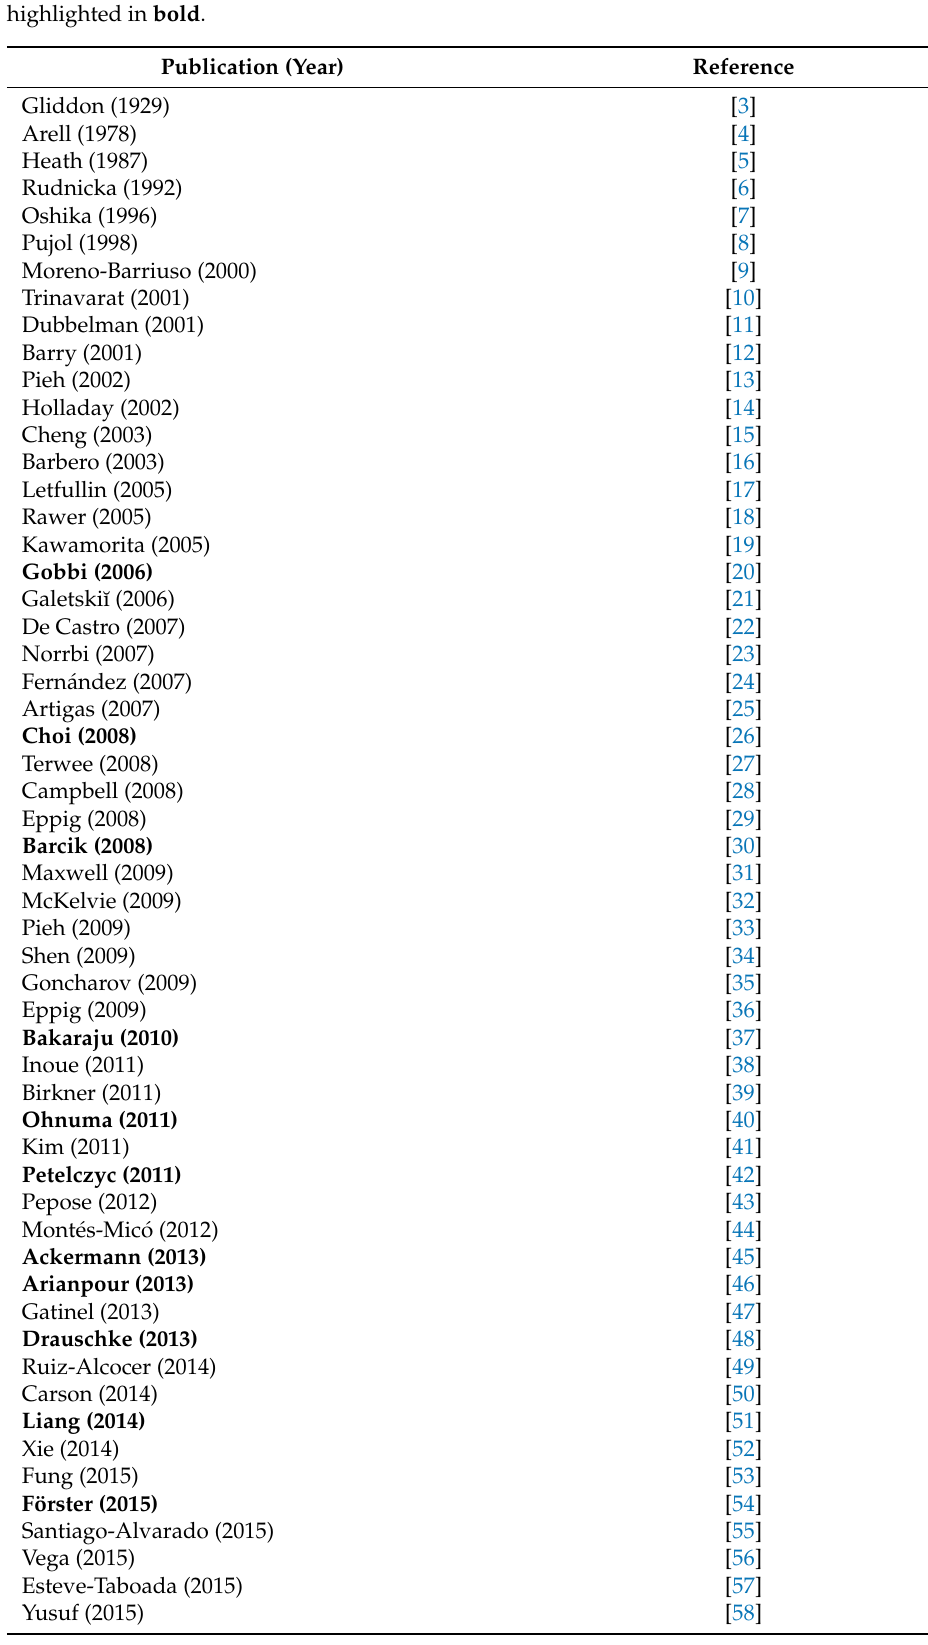
Table 1. Publications involving physical eye models considered in this review. Patented inventions are at the end of the table. Publications considered relevant for human vision applications are highlighted in bold